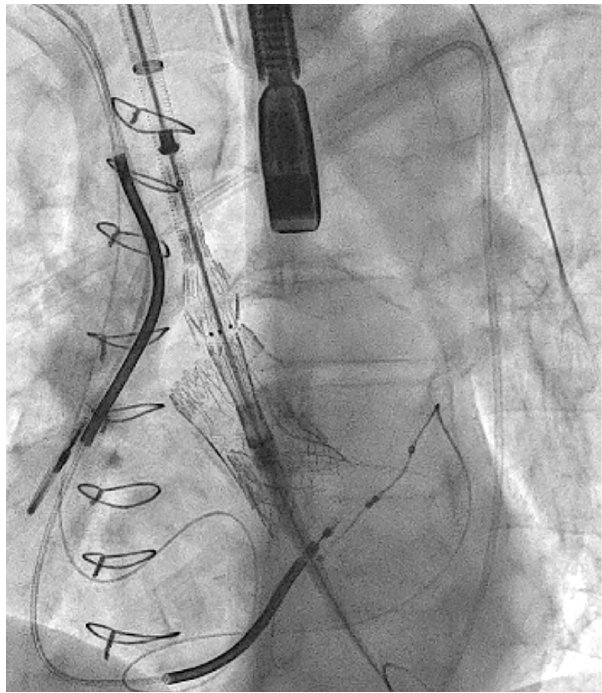
Figure 3. TEVAR fluoroscopy: TEVAR fluoroscopy 2: initial implantation of JOTEC 38 × 50 mm abdominal SG extension.